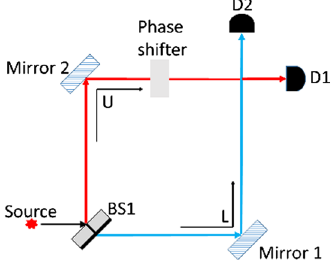
FIG. 3. Mach-Zehnder interferometer setup with a phase shifter in the upper path.